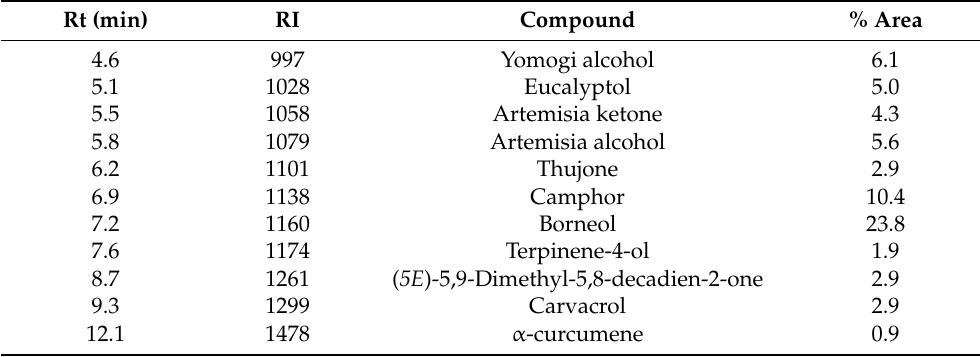
Table 4. Chemical composition of the peak area contribution of Achillea millefolium L. ethanolic extract (UAE-100 extract) of the volatile fraction identified by